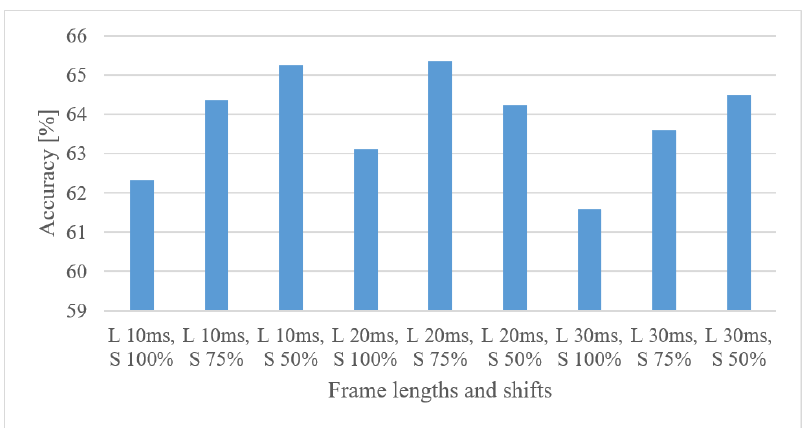
Figure 3. Averaged accuracies for 10, 20, 30 ms frame lengths (L) with 100, 75, 50% shifts (S) and a 0–8 kHz power spectrogram.